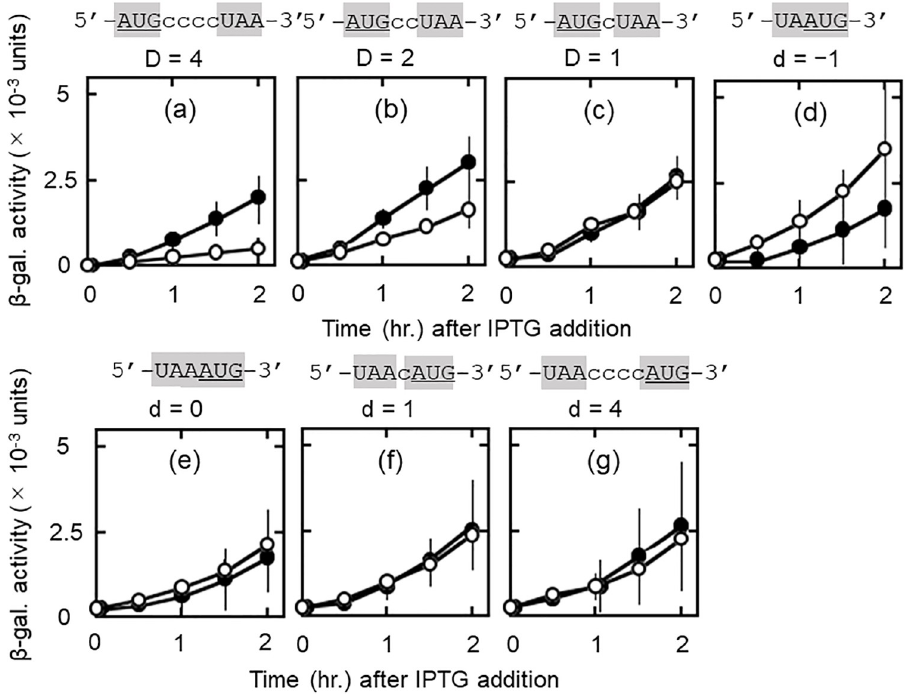
Fig 5. The distance between AUG and UAA of the junction sequence influences downstream reading only in the presence of RRF. Nucleotide sequence and the distance (D and d) between AUG and UAA at the junction regions are indicated above each panel. AUG is the initiation codon of d-ORF and in frame with the reporter lacZ ( Δ 27) gene. UAA is the termination codon of u-ORF. D represents distance in nucleotides when AUG is upstream of UAA while d represents distance when AUG is downstream of UAA. The minus sign ( − ) in panel (d) indicates that UAA and AUG are overlapped by one nucleotide (d = − 1). Cases where AUG is located upstream of UAA with distance 3 and 0 nucleotides (D = 3 and 0) are not shown because AUG is in frame with downstream